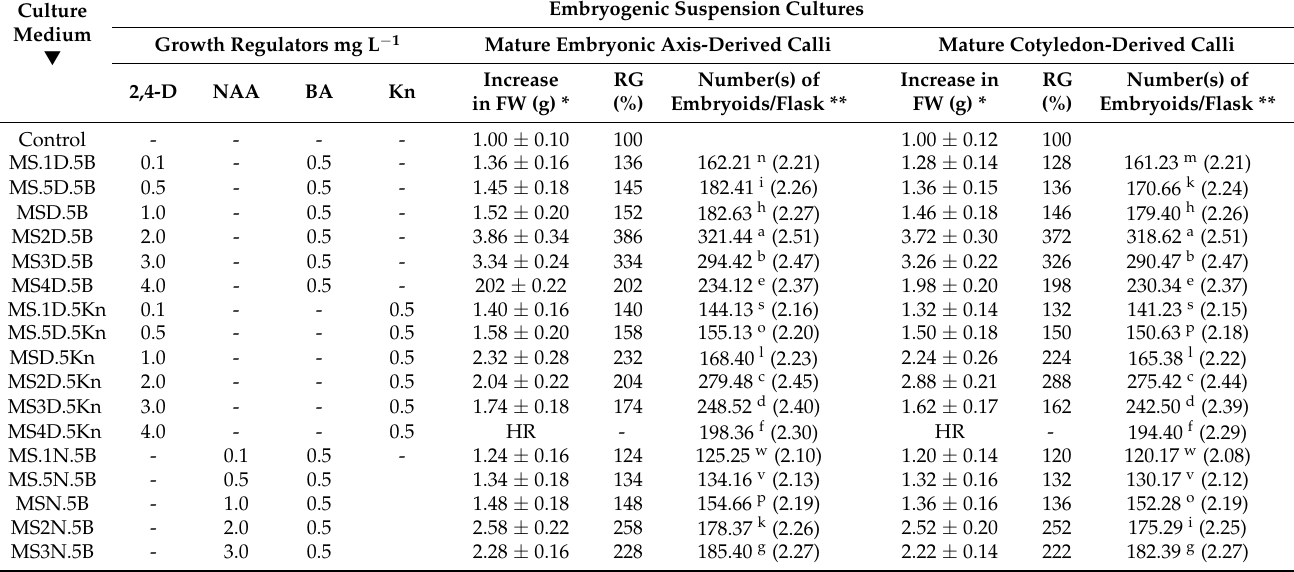
Table 3. Cumulative influence of supplemented cytokinins and auxins in varying levels and combinations on growth of sandalwood cell suspension